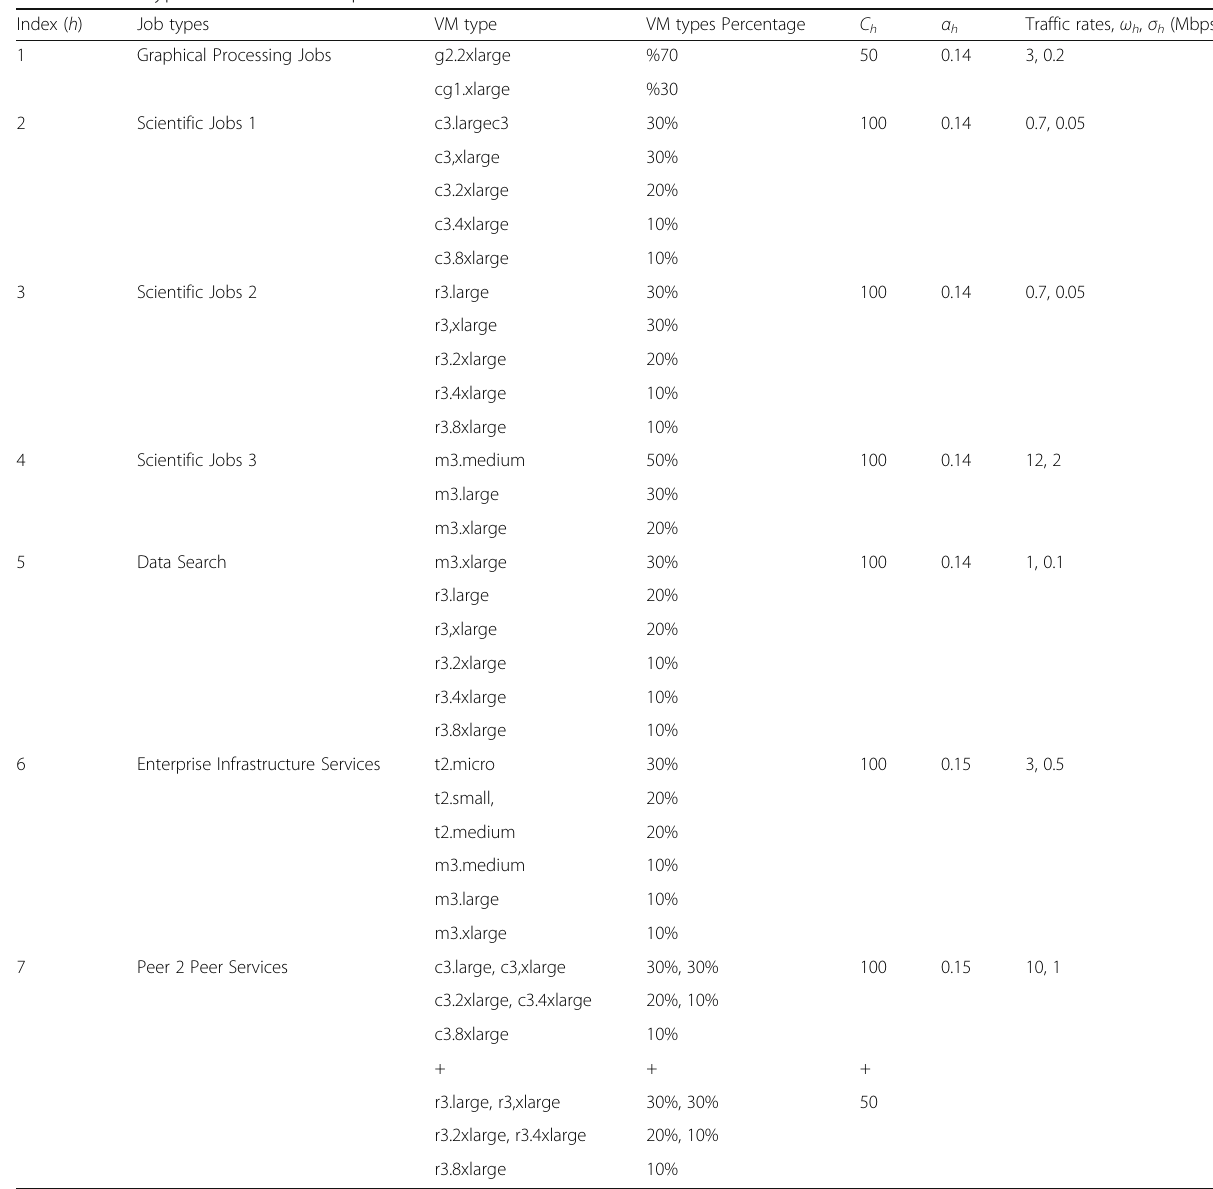
Table 8 Jobs Types and their VM